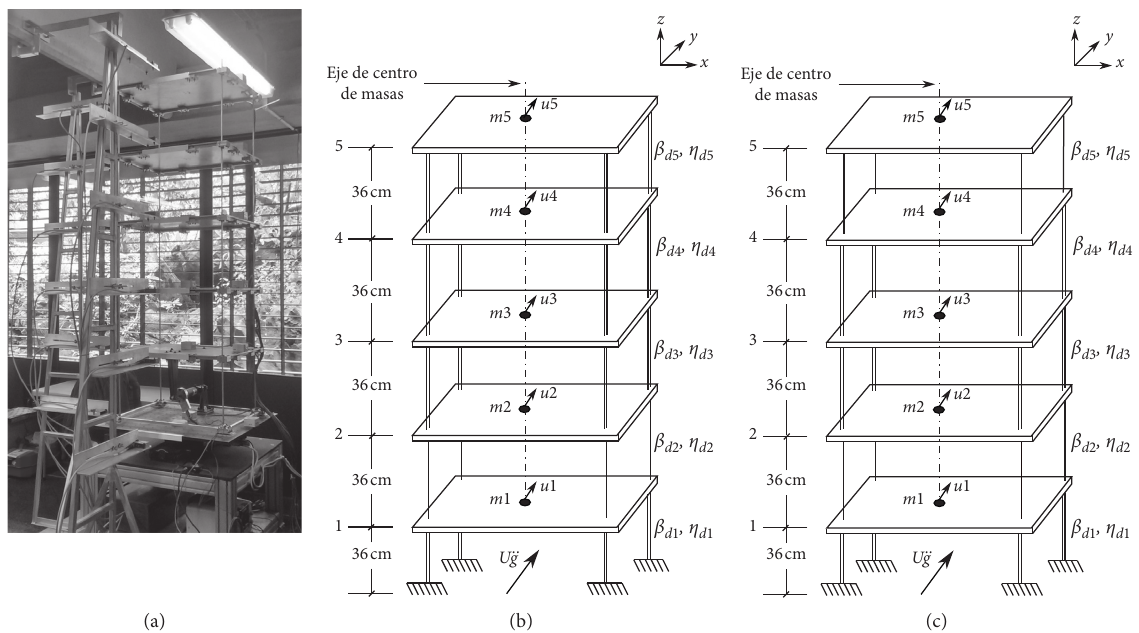
Figure 4: Experimental setup. (a) Scaled five-story building prototype. (b) Building with the presence of damage on the second story. (c) Building with the presence of damage on the second and the fifth